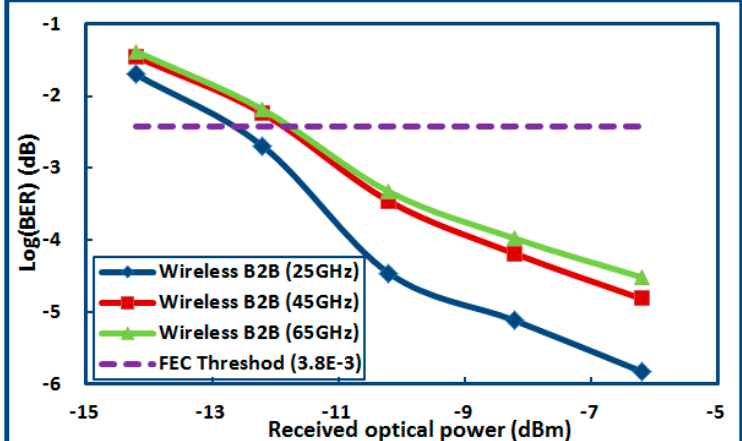
Figure 17. Relational curve between ROP and BER in the wireless link.